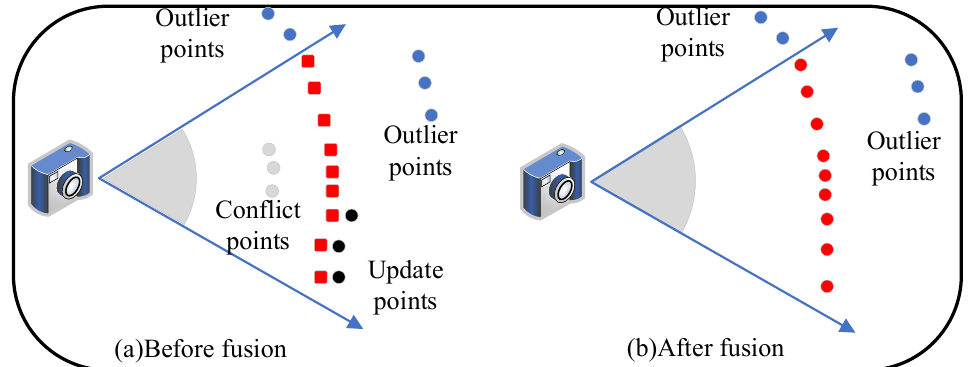
Figure 3. Data association. New generated surfels (red squares) are fused with surfels (dots) of the local